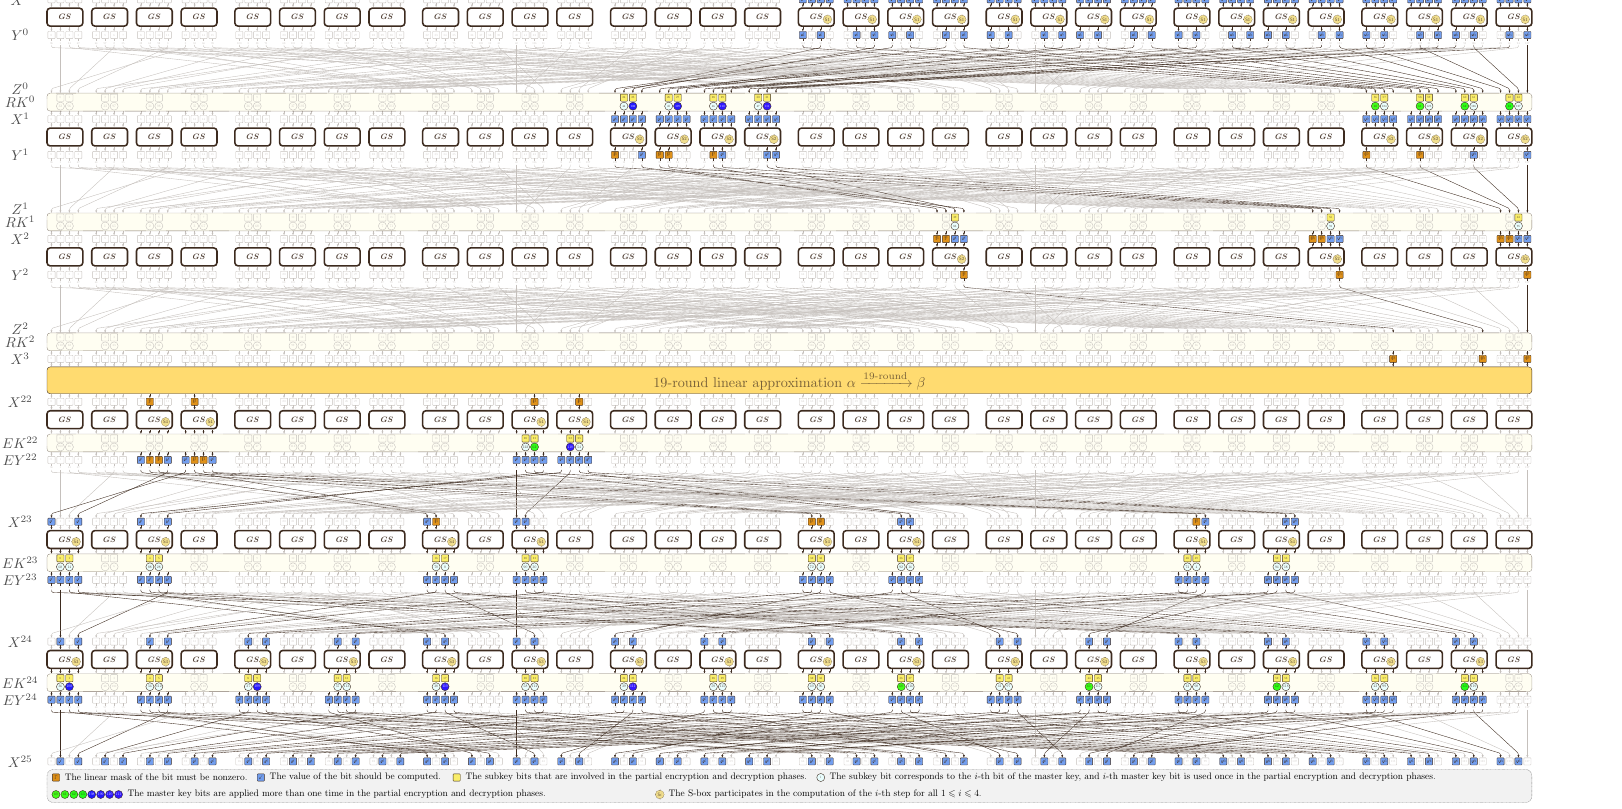
Figure 2: Key-recovery attack on 25-round GIFT-128